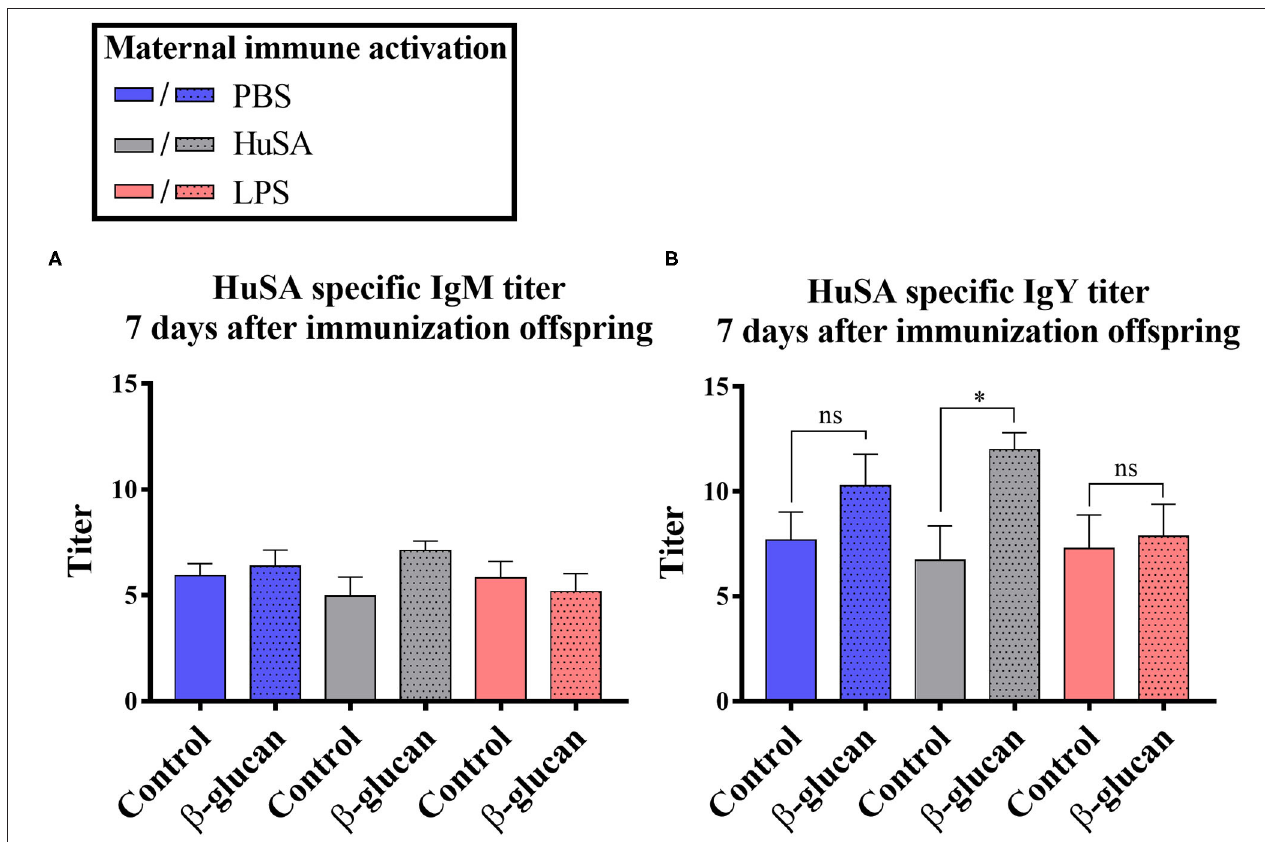
FIGURE 4 | Results of experiment 2 with IgM and IgY anti-HuSA titers of chicks originating from hens immunized with either PBS, HuSA or LPS. The chicks were fed either the control diet or the diet enriched with β -glucan. Data of offspring 7 days post immunization are presented. (A) IgM anti-HuSA titers 7 days after the HuSA immunization and (B) IgY anti-HuSA titers 7 days after the HuSA immunization. Each bar represents means ± SEM, and N = 10 chickens per group. Effects are represented as * and were considered to be significant when P ≤ 0.05. ns, not